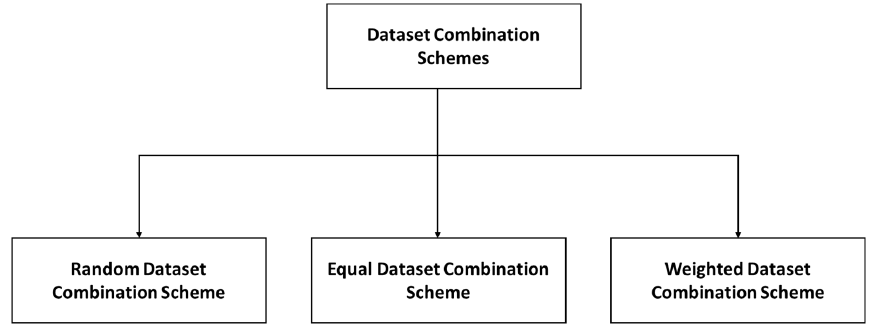
Figure 4. Types of wireless dataset combination schemes.